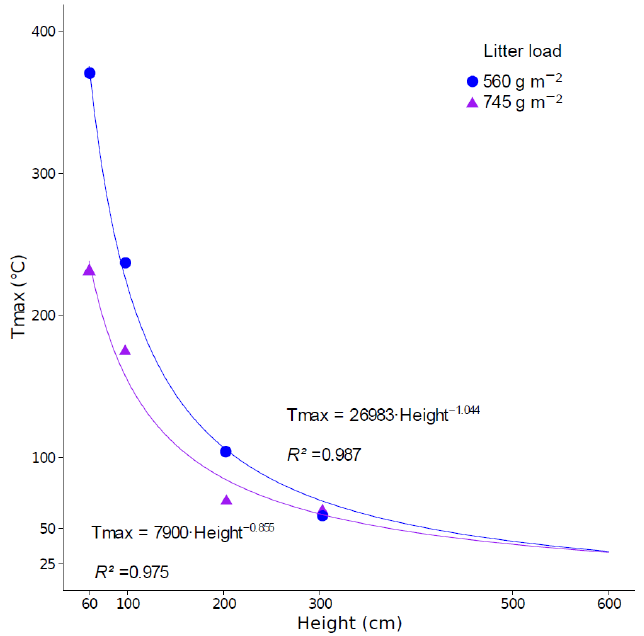
Figure 9. Maximum temperature measured at different heights during two prescribed burns, with litter loads of 560 and 745 g m – 2 (the average fuel load was 656 g m – 2 in present study), according to [75] and temperature extrapolation up to 600 cm high using a non-linear least squares model. Trunk heating (on P. halepensis ) negatively affects photosynthesis for totally burned trees, compared to the control and partially burned trees [54]. This decrease in A was as-